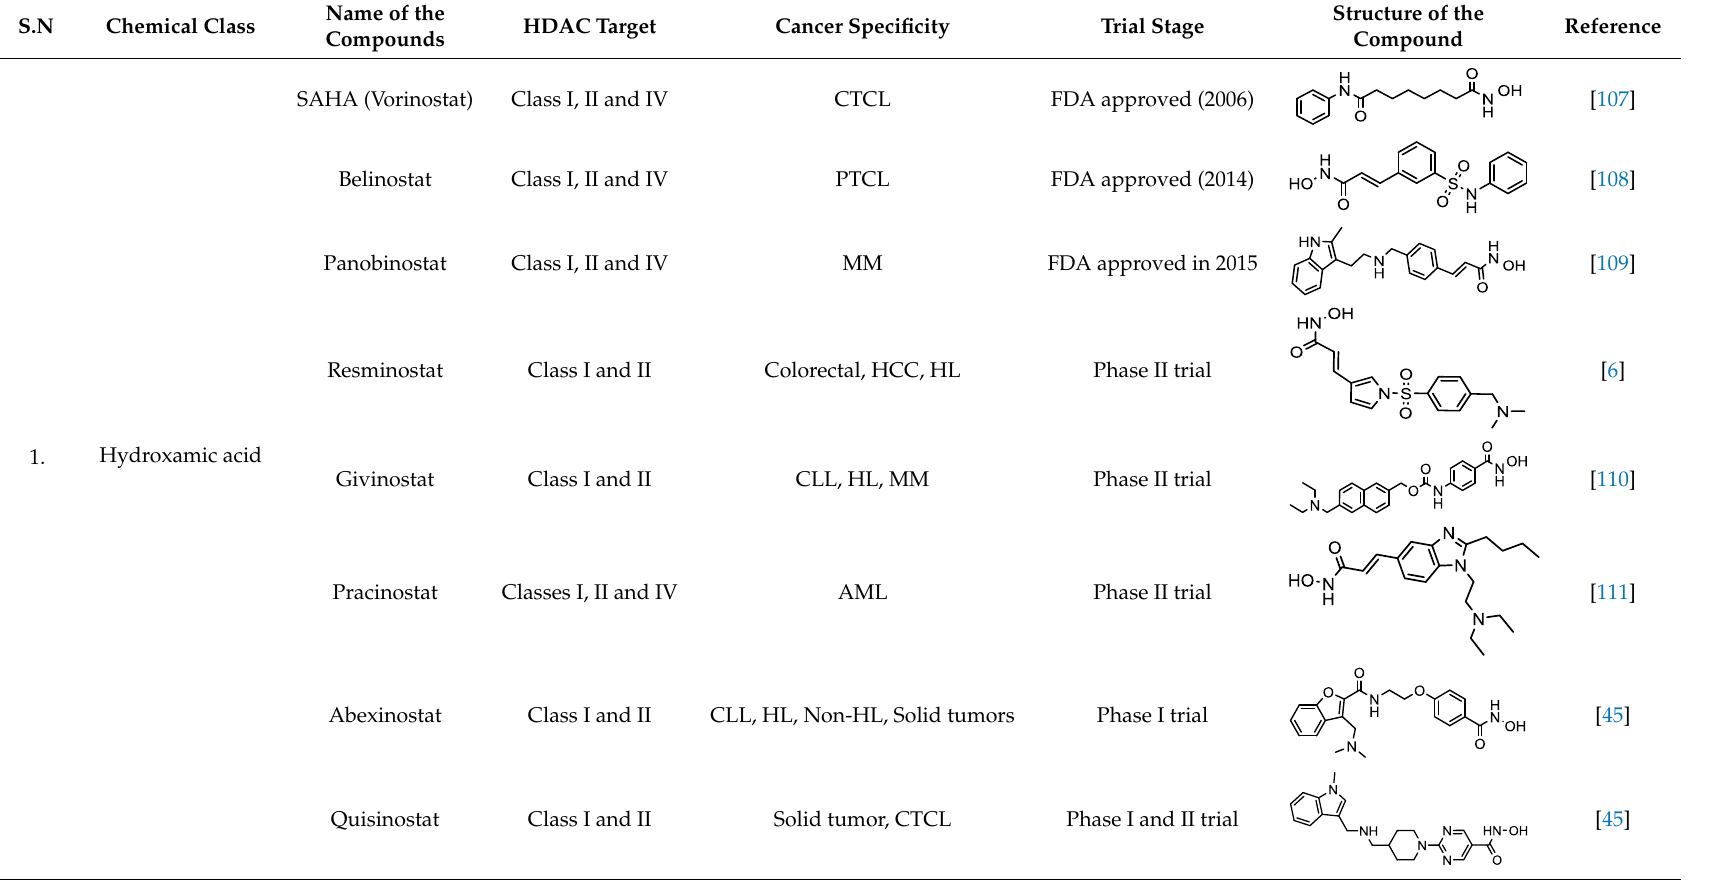
Table 3. FDA approved and under clinical trials histone deacytylase inhibitors (HDACi).